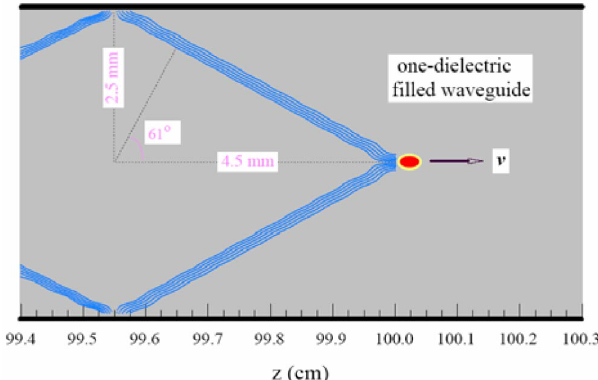
(cid:4) 5 : 7 and r p (cid:2) with (cid:3) (cid:1) r r